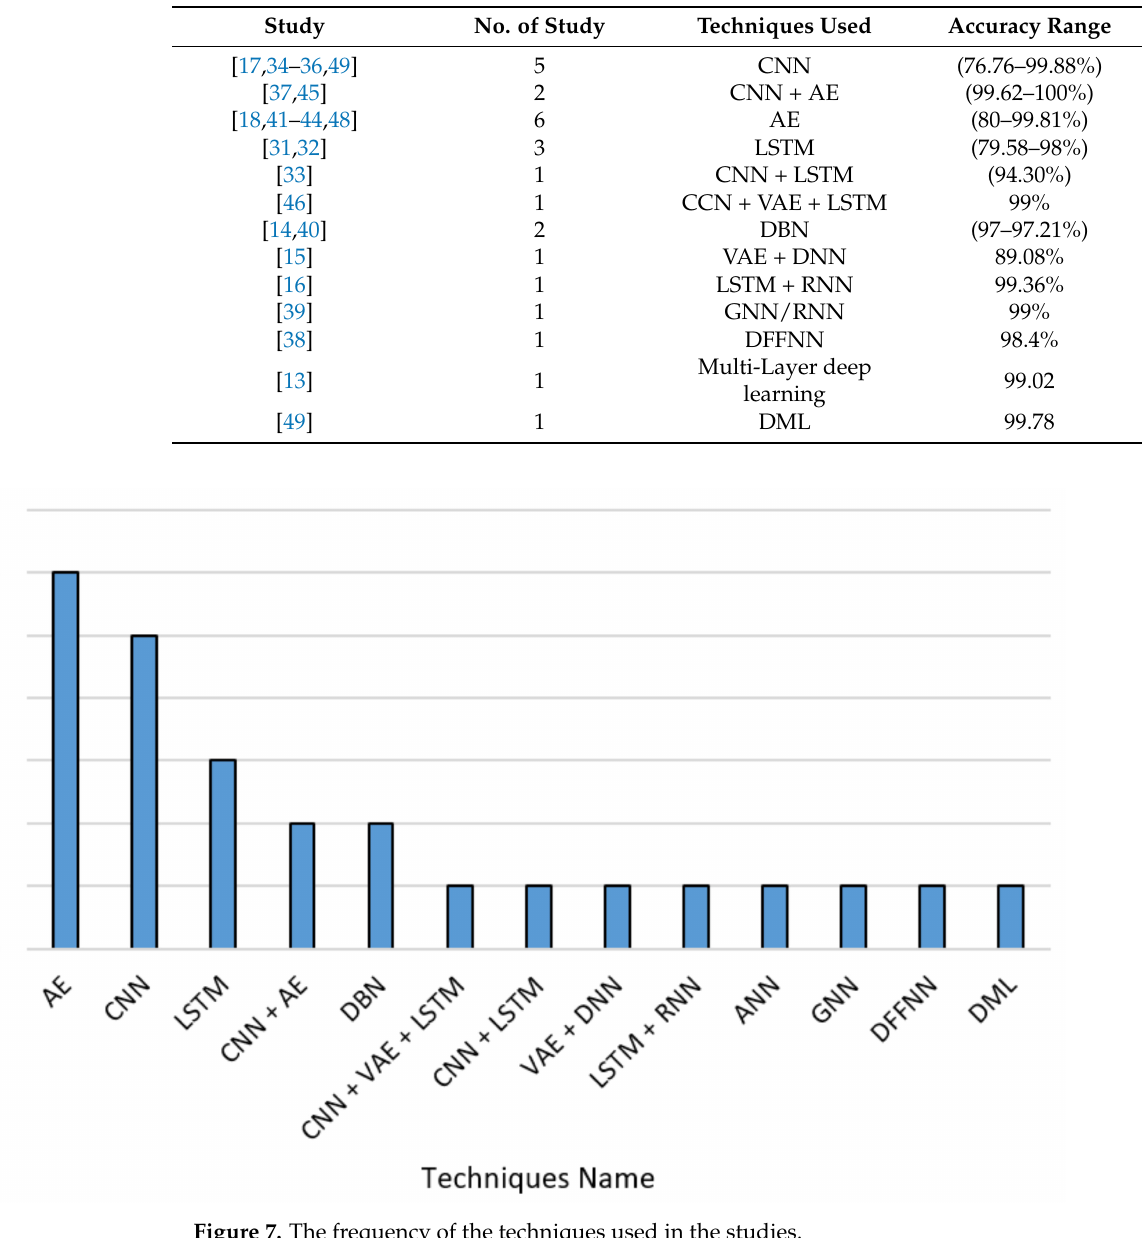
Figure 7. The frequency of the techniques used in the